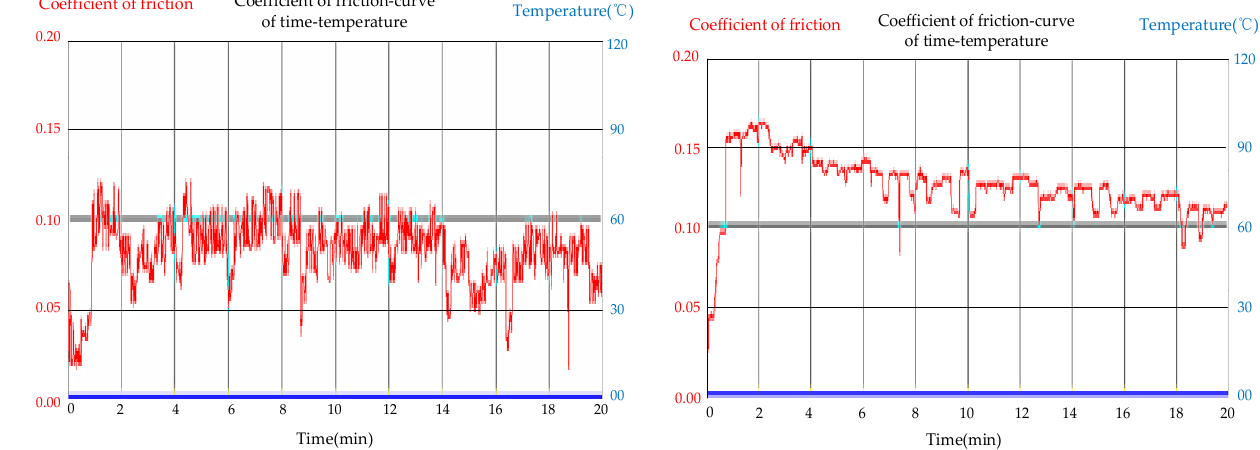
Figure 12. The friction coefficient curves of the coating and the substrate: ( a ) the coating; (b ) Cr12MoV substrate.